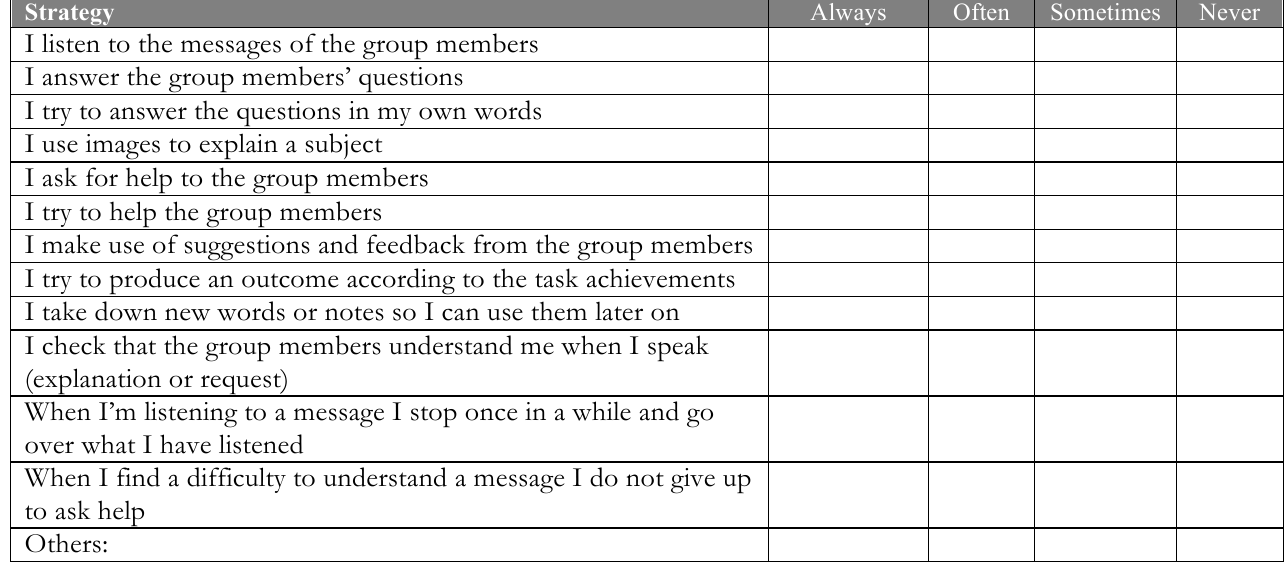
Table 3. Self-assessment student